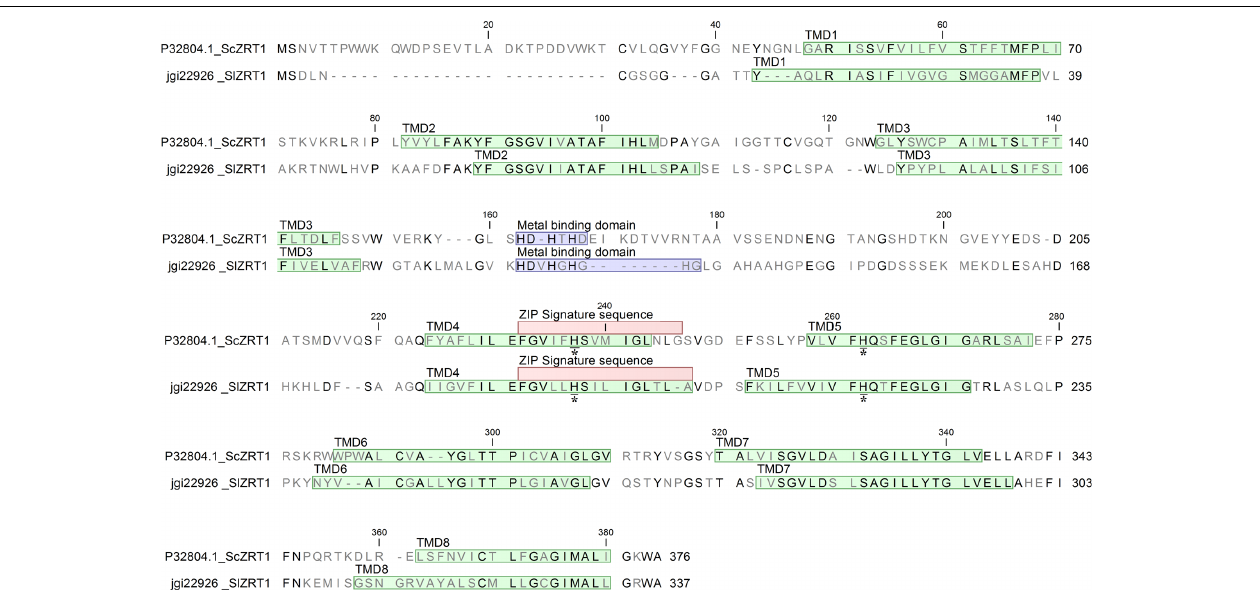
FIGURE 2 | Alignment of SlZRT1 and ScZRT1 protein sequences. The eight transmembrane domains (TMDs) predicted by topology prediction program TMHMM2.0 are indicated in green, the putative metal binding domains in blue, the ZIP signature sequence as described by Eng et al. (1998) in red, and two conserved histidines with an asterisk (located in TMD4 and TMD5).